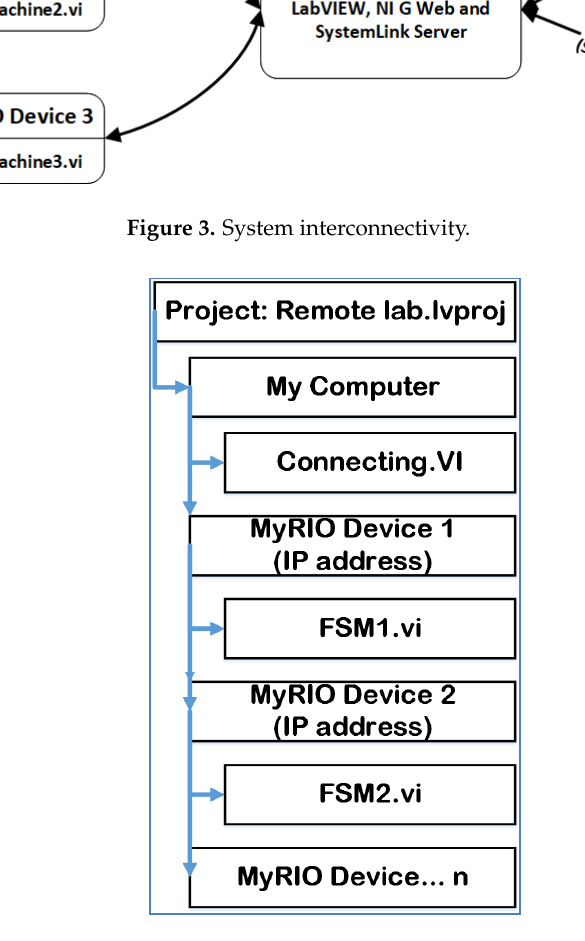
Figure 3. System interconnectivity.